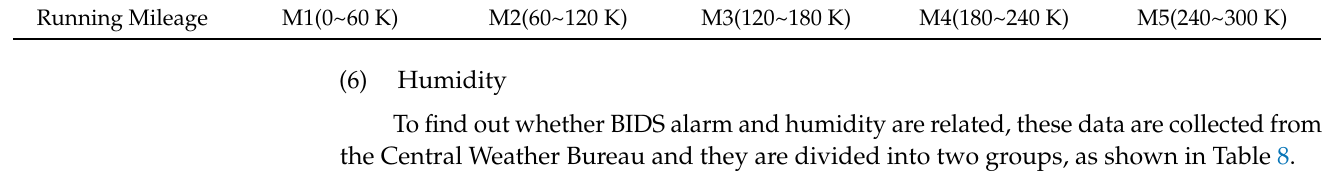
Table 8. Humidity groups.